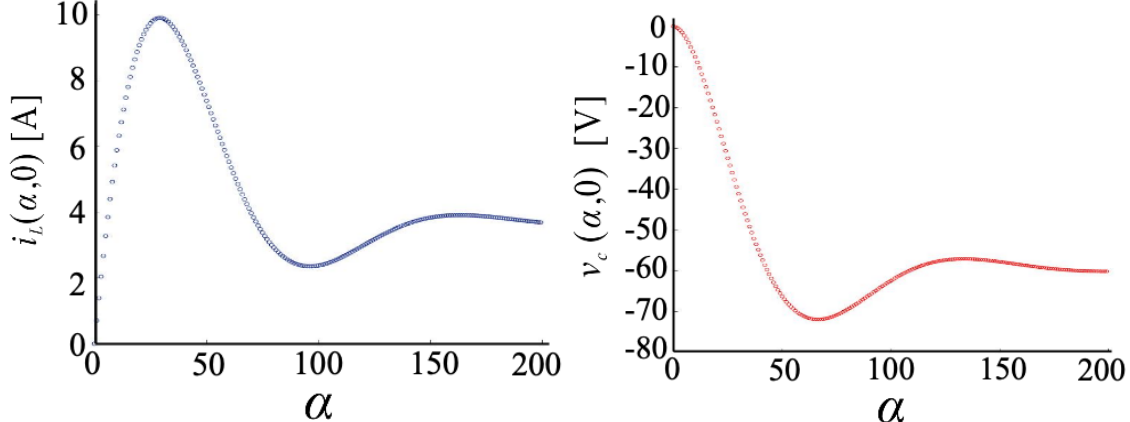
Figure 5. Graph of ICCV at the beginning of the α -th switching period from S 1 parameters through Equations (33) and (34).